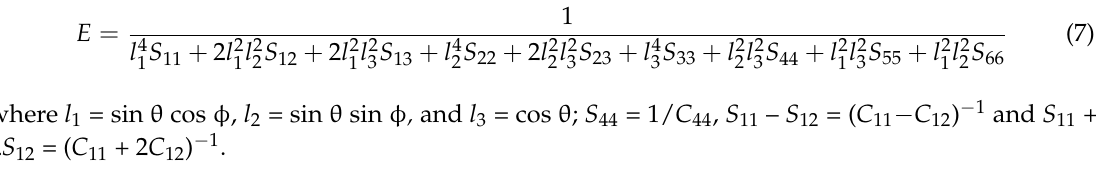
Table 2. Elastic constants of the substitution interface (1Si–6N), double-substitution interface,